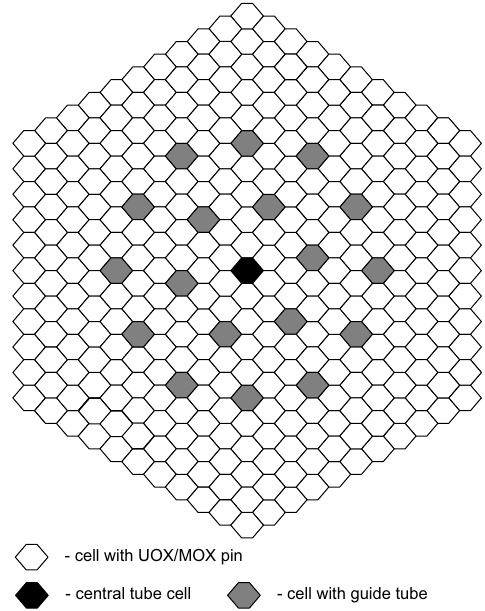
Fig. 2. The standard VVER-1000 FA con fi guration for REMIX, REMIX(MOX)